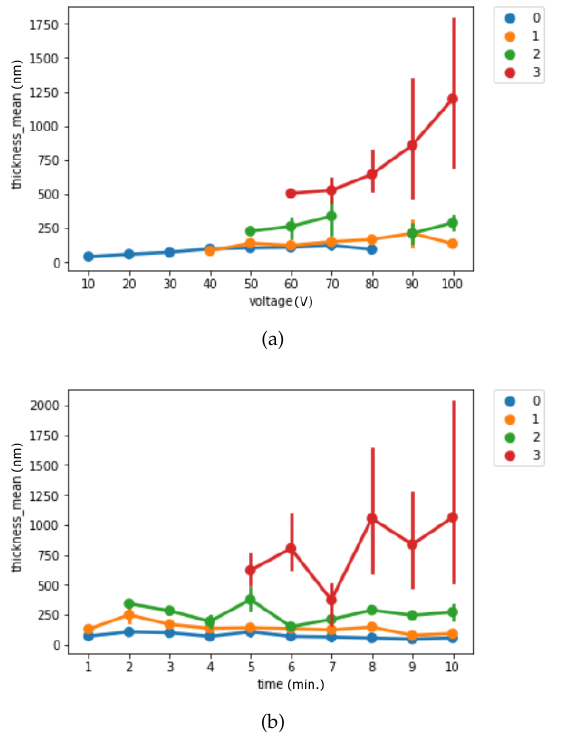
Figure 4. ( a ) Binary classification result by voltage from 10 V to 100 V ( b ) Binary classification result by time from 1 min to 10 min (line indicates 95%